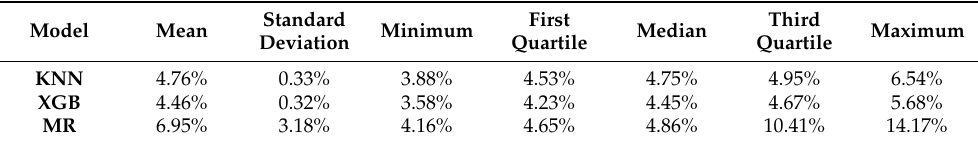
Figure 5. Kernel density estimations of rRMSE distributions for models based on training datasets with 68 observations. Table 3. Selected measures of a central tendency of relative root mean square errors for the analyzed models in 1000 draws (a training set of 118 observations).